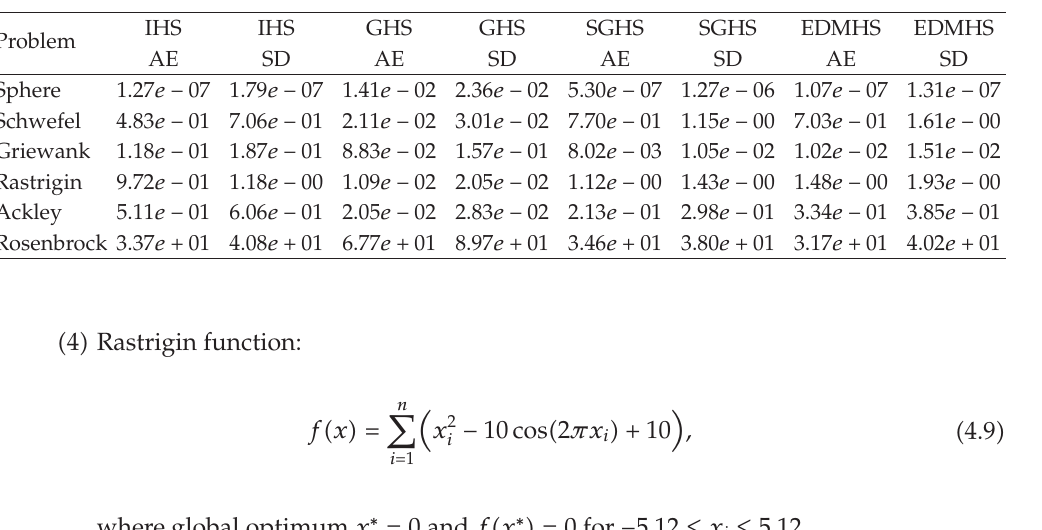
Table 6: AE and SD generated by the compared